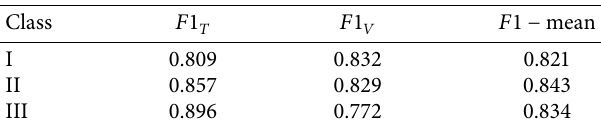
Figure 10: Comparison of results obtained using different MTS classification algorithms. Table 5: F1